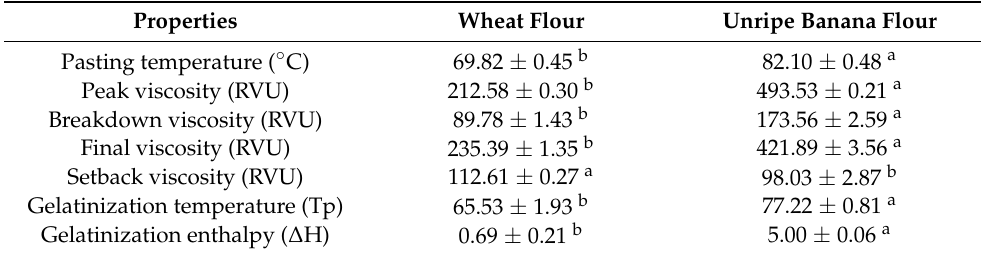
Table 2. Thermal and pasting properties of wheat flour and unripe banana flour. Properties Wheat